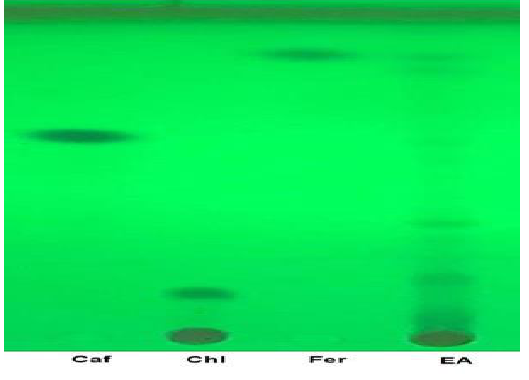
Figure 2. TLC plates for analyzed ethyl acetate fraction developed in the